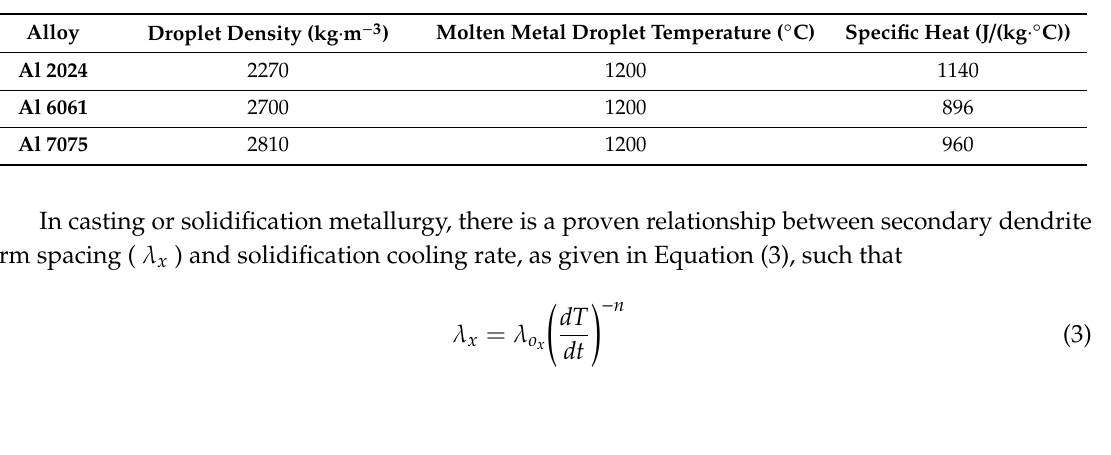
Table 1. Droplet density, molten metal droplet temperature, and specific heat associated with the rapidly solidified aluminum alloys considered herein: Al 2024, Al 6061, and Al